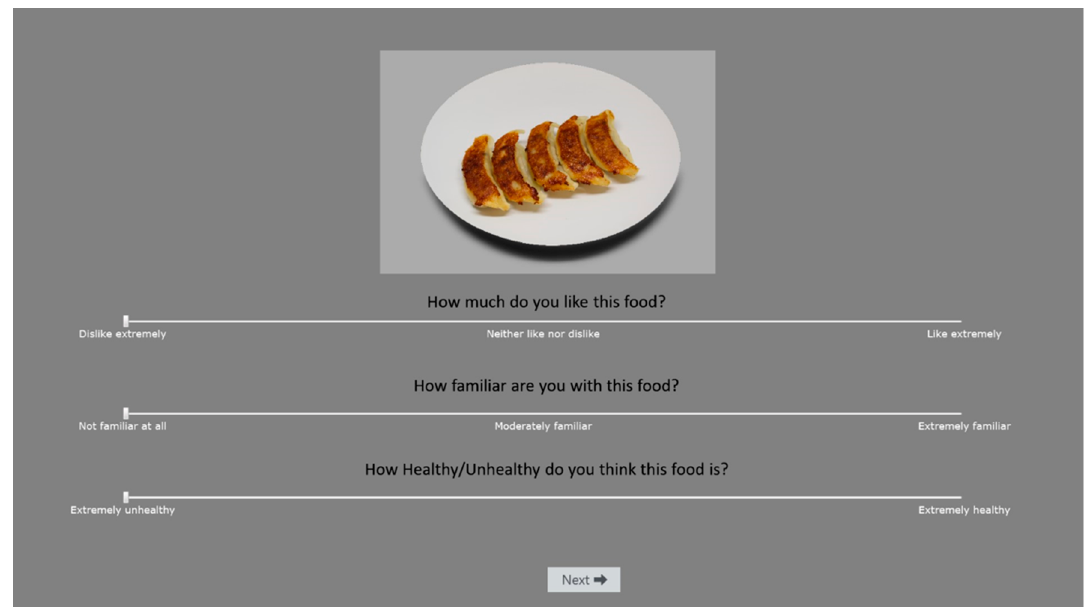
Figure A1. Example of a question in the follow-up questionnaire (liking, familiarity, and